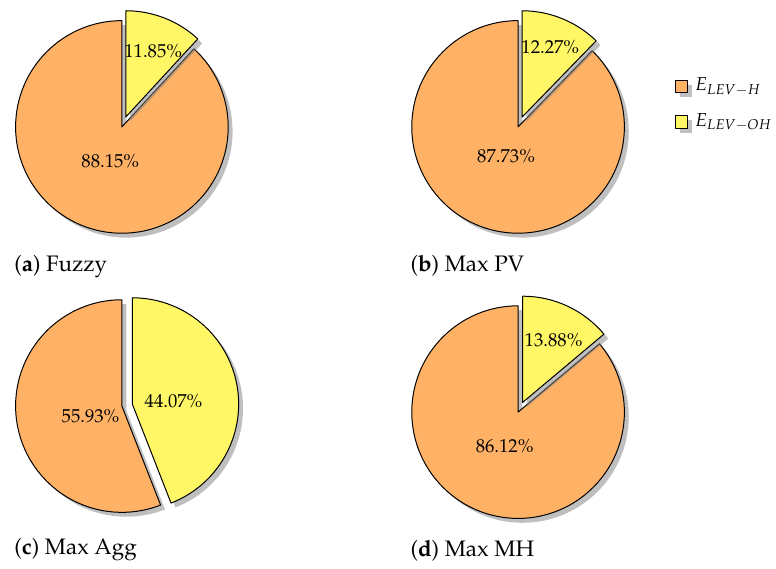
Figure 10. Distribution of local EVs